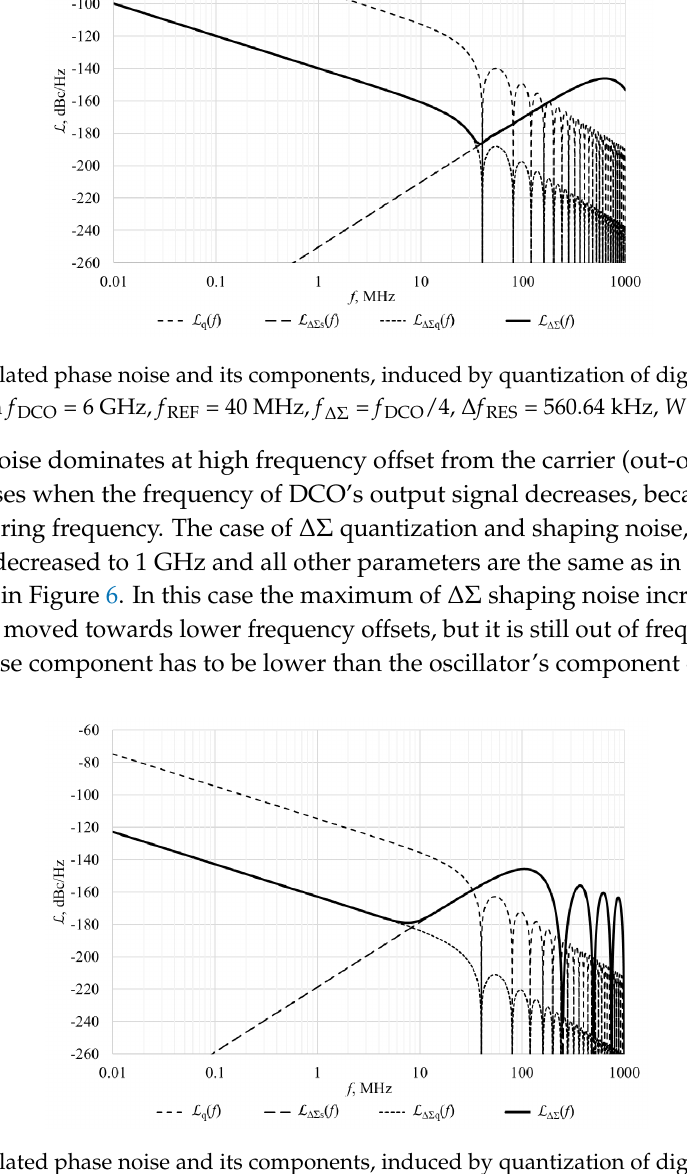
Figure 6. Calculated phase noise and its components, induced by quantization of digitally controlled oscillator, when f DCO = 1 GHz, f REF = 40 MHz, f ΔΣ = f DCO /4, Δ f RES = 40 kHz, W = 8, n = 3.